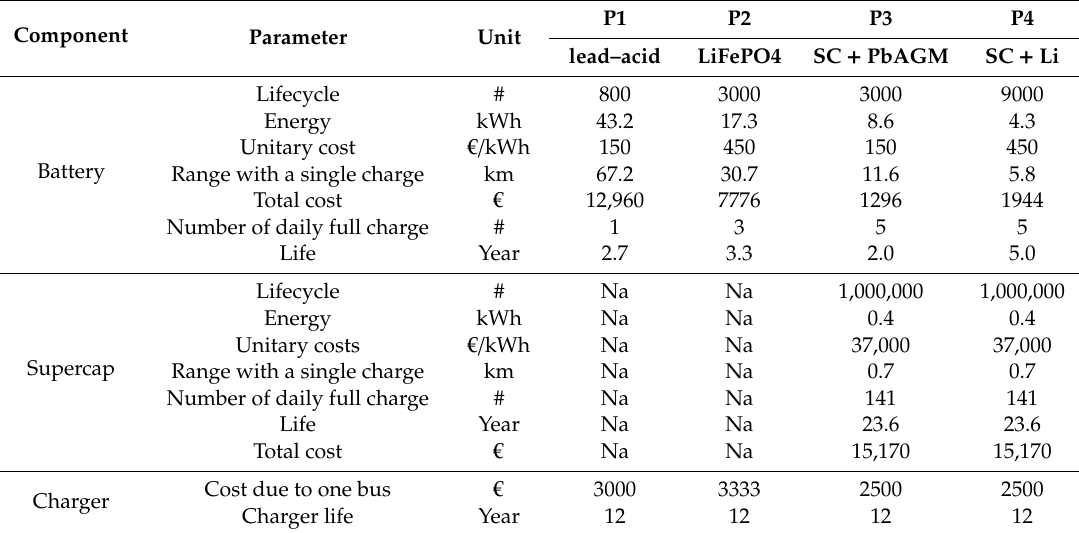
Table 6 is divided into main components: battery, supercap and charger; each component is detailed in the